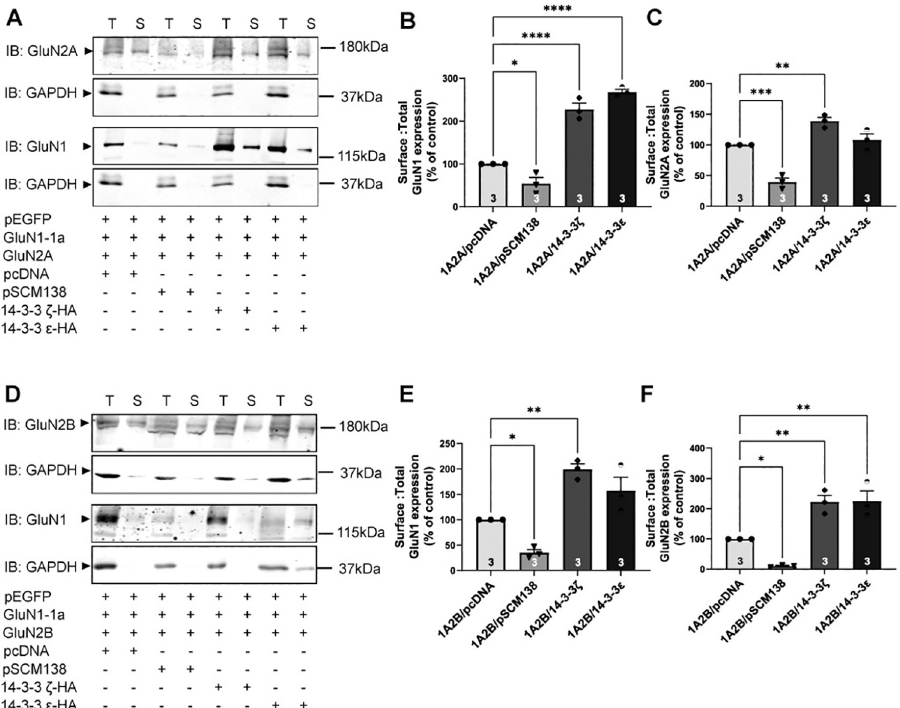
Fig 4. 14-3-3 proteins promote surface expression of GluN1, GluN2A, and GluN2B subunits. A , Surface and total expression of GluN1 and GluN2A was assessed upon 14-3-3 protein inhibition or overexpression in tsA201 cells via surface biotinylation assay. As controls, cell lysates expressing pcDNA (vector) were used for comparison and GAPDH was probed for all immunoblots as a loading control. IB, antibody used for immunoblot analysis. Representative western blot images of total (T) and surface (S) expression of GluN1 and GluN2A from cells expressing GluN1-1a and GluN2A with either pcDNA (vector control), pSCM138 (14-3-3 inhibitor), or 14-3-3 z or ε isoforms. B , Illustrate surface: total GluN1 expression levels normalized to cells expressing pcDNA control (one-way ANOVA with Bonferroni’s multiple comparisons test when compared to 1A2A/pcDNA: 1A2A/pSCM138, � p = 0.0458, n = 3; 1A2A/ 14-3-3 z , ���� p < 0.0001, n = 3; 1A2A/14-3-3 ε , ���� p < 0.0001, n = 3). C , Illustrate surface: total GluN2A expression levels normalized to pcDNA control (one-way ANOVA with Bonferroni’s multiple comparisons test when compared to 1A2A/pcDNA: 1A2A/pSCM138, ��� p = 0.0006, n = 3; 1A2A/14-3-3 z , �� p = 0.0098, n = 3; 1A2A/14-3-3 ε , p > 0.9999, n = 3). D , Surface and total expression of GluN1 and GluN2B was assessed upon 14-3-3 protein inhibition or overexpression in tsA201 cells via surface biotinylation assay. Representative western blot images of total (T) and surface (S) expression of GluN1 and GluN2B from cells expressing GluN1-1a and GluN2B with either pcDNA, pSCM138, or 14-3-3 z or ε isoforms. E , Illustrate surface: total GluN1 expression levels normalized to pcDNA control (one-way ANOVA with Bonferroni’s multiple comparisons test when compared to 1A2B/pcDNA: 1A2B/pSCM138, � p = 0.0419, n = 3; 1A2B/14-3-3 z , �� p = 0.0042, n = 3; 1A2B/14-3-3 ε , p = 0.0733, n = 3). F , Illustrate surface: total GluN2B expression levels normalized to pcDNA control (one-way ANOVA with Bonferroni’s multiple comparisons test when compared to 1A2B/pcDNA: 1A2B/pSCM138, � p = 0.0410, n = 3; 1A2B/14-3-3 z , �� p = 0.0082, n = 3; 1A2B/ 14-3-3 ε , �� p = 0.0070, n = 3). Error bars indicate SD.